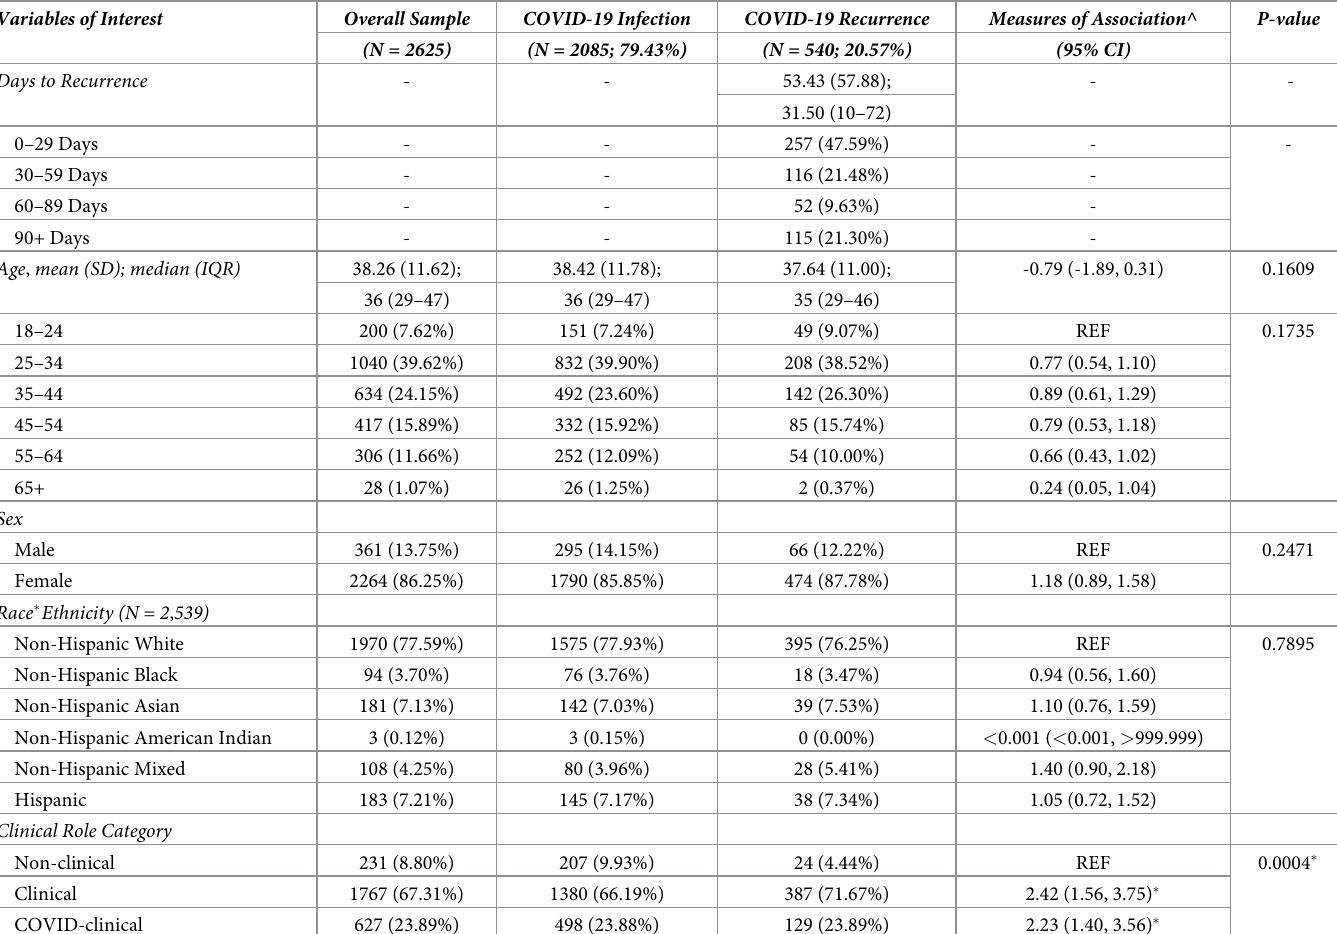
Table 4. Demographics of sample of healthcare employees, overall and by COVID-19 recurrence